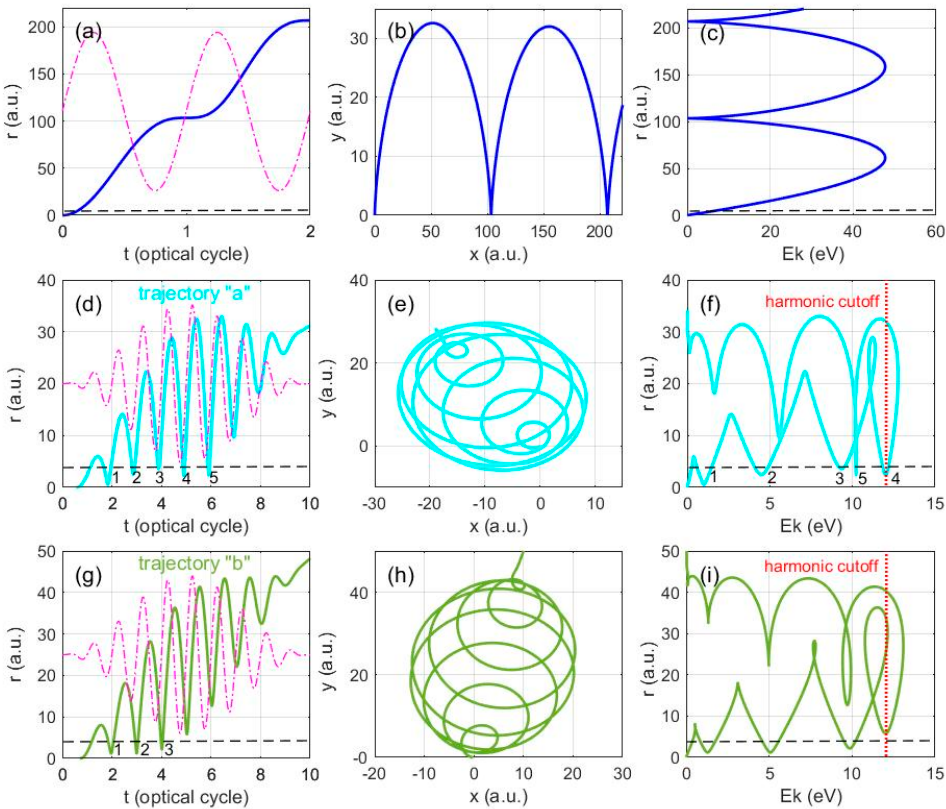
Figure 3. A typical trajectory for the laser field with a constant amplitude ( a – c ) and two typical trajectories for the sine-squared laser field ( d – i ). The first, second, and third columns present the time-dependent distance between the electron and the parent ion r , two-dimensional evolution of the electron displacement, and the evolution of the electron kinetic energy during the trajectory. The x component of the driving field is also presented by the pink dash-dotted curves in panels ( a , d , g ). The black dashed lines in the first and third columns denote the position r = 4.0 a.u. The red dotted lines in the third column denote the maximum return kinetic energy of the electron, which is consistent with the harmonic cutoff.